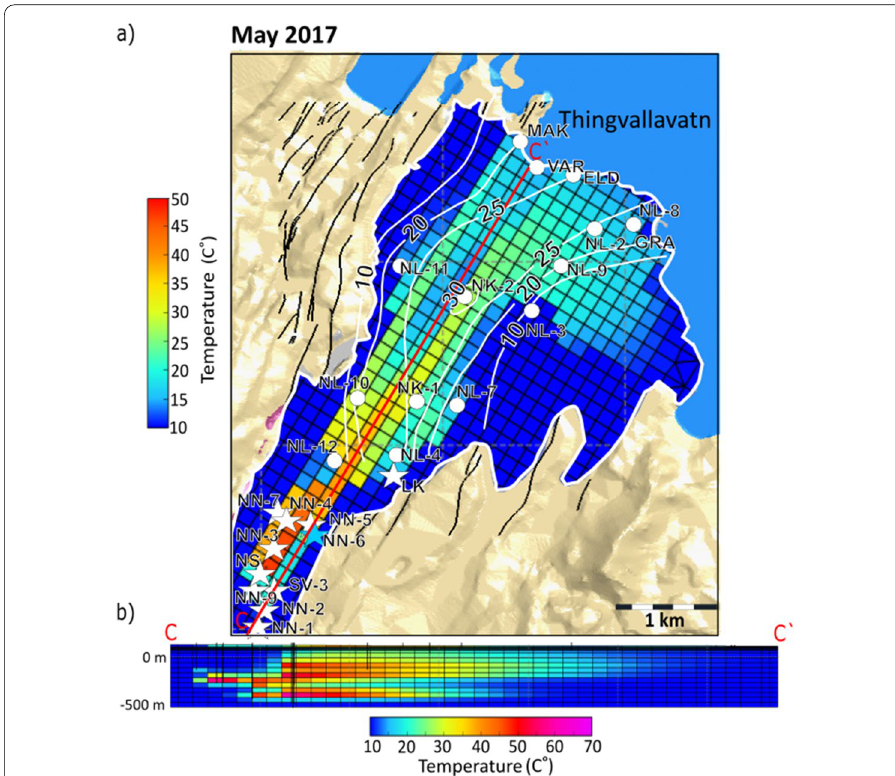
Fig. 14 a Comparison between temperature ÍSOR map and simulation for May 2017. White dots are the monitoring station, white stars are the injection wells and blue star is the injection well NN‑6 chosen for the tracer test. Groundwater temperature 1 m below the groundwater table. b Cross section along the most permeable fault